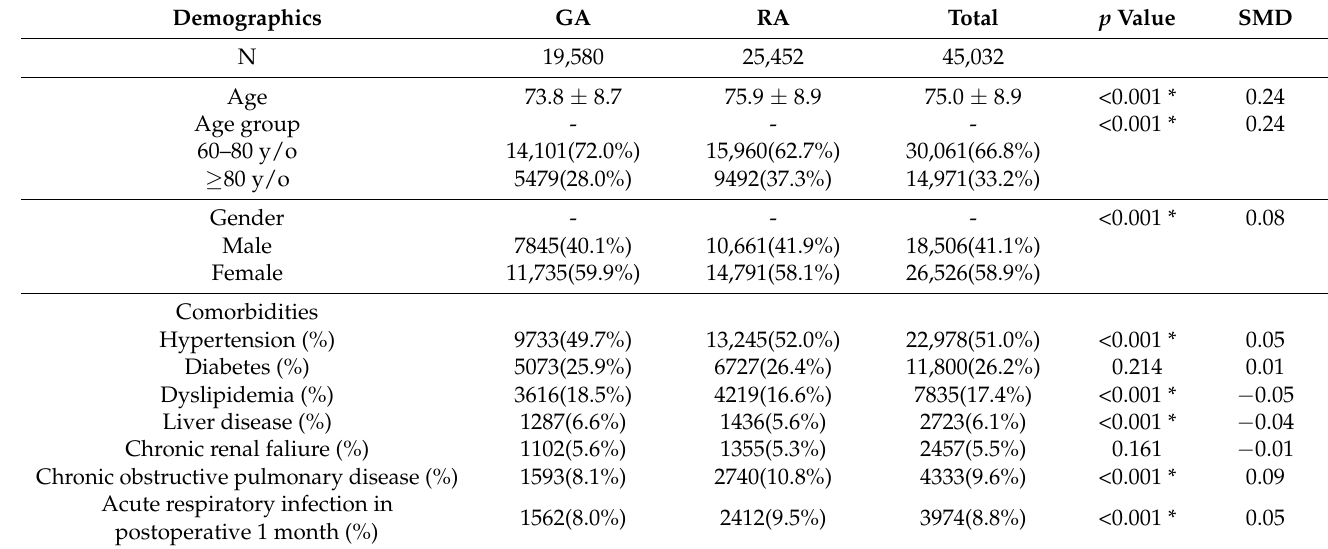
Table 1. Demographics of the GA and SA groups of the patients receiving surgery for incidents of lower-limb fractures ( n =